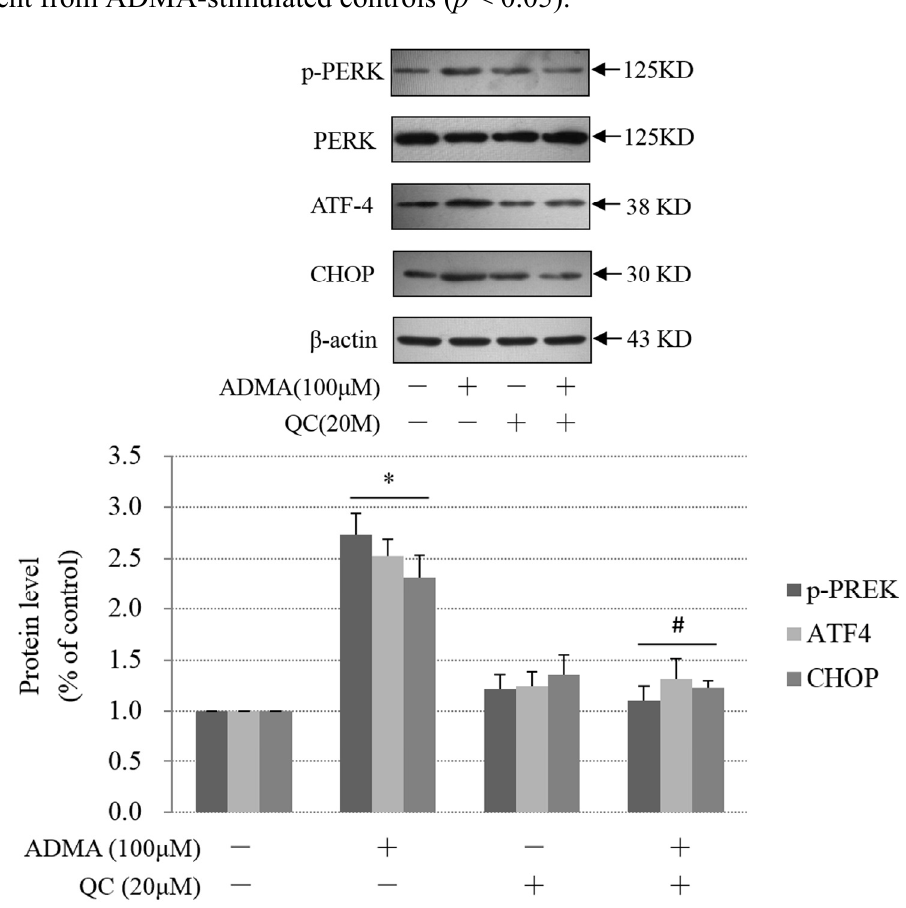
Figure 5. QC inhibited ADMA-induced ER stress. ( A ) QC prevented the ER stress pathway by down-regulating the expression of PERK-ATF4-CHOP. GEnCs were treated for 1 h in the presence or absence of 20 μ M QC prior to incubation with 100 μ M ADMA for 24 h. Cells were then lysed, and levels of Thr 981 phosphorylated PERK (p-PERK), ATF4, and CHOP were assayed by western blot analysis. β -Actin or PERK is shown as a loading control. Results are the mean ± SD ( n = 3); ( B ) Real-time PCR analysis of ATF4 and CHOP mRNA levels in cells exposed to ADMA (100 μ M) for 24 h in the absence or presence of QC (means ± SD, n = 3); ( C ) Cells were transfected with graded concentrations of pcDNA3-GADD153 expression vectors or the control empty vector, and incubated for 24 h. Cells were pretreated with 20 μ M QC for 1 h and then restimulated with 100 μ M ADMA for a further 24 h. Apoptosis was assessed by flow cytometry (mean ± SD, n = 3); and ( D , E ) QC inhibited ADMA-induced IRE1 expression, JNK phosphorylation and c-Jun phosphorylation. GEnC were treated for 1 h in the presence or absence of 20 μ M QC before incubation with 100 μ M ADMA for 24 h. Cells were then lysed, and levels of IRE1, p-JNK and p-c-Jun were assayed by western blot analysis. Results are the mean ± SD ( n = 3). p < 0.05 by ANOVA was considered significant. * different from controls ( p < 0.05); # different from ADMA-stimulated controls ( p <